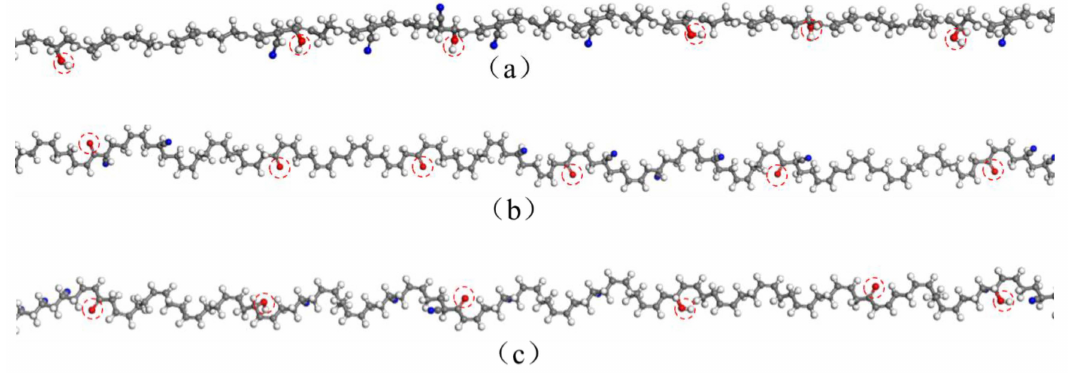
Figure 3. The aged rubber molecule chains modified by oxidation products: ( a ) hydroxyl groups; ( b ) carbonyl groups; ( c ) hydroxyl groups and carbonyl groups.